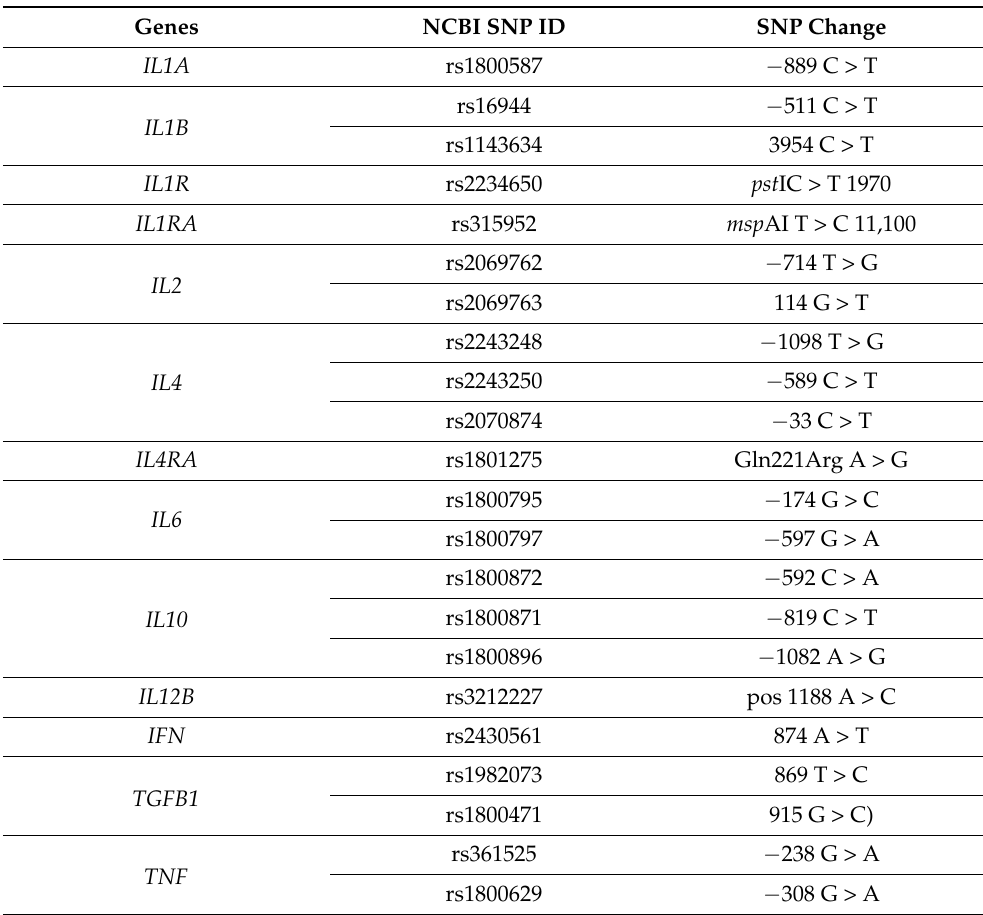
Table 1. SNPs analyzed in the